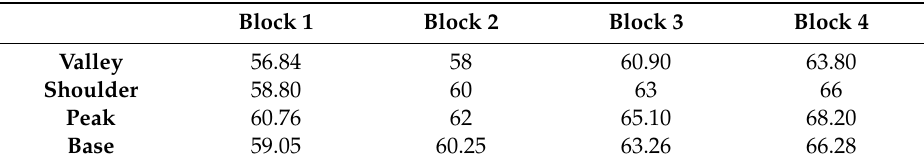
Table 4. Weekly forward contract unit price ( € / MWh).